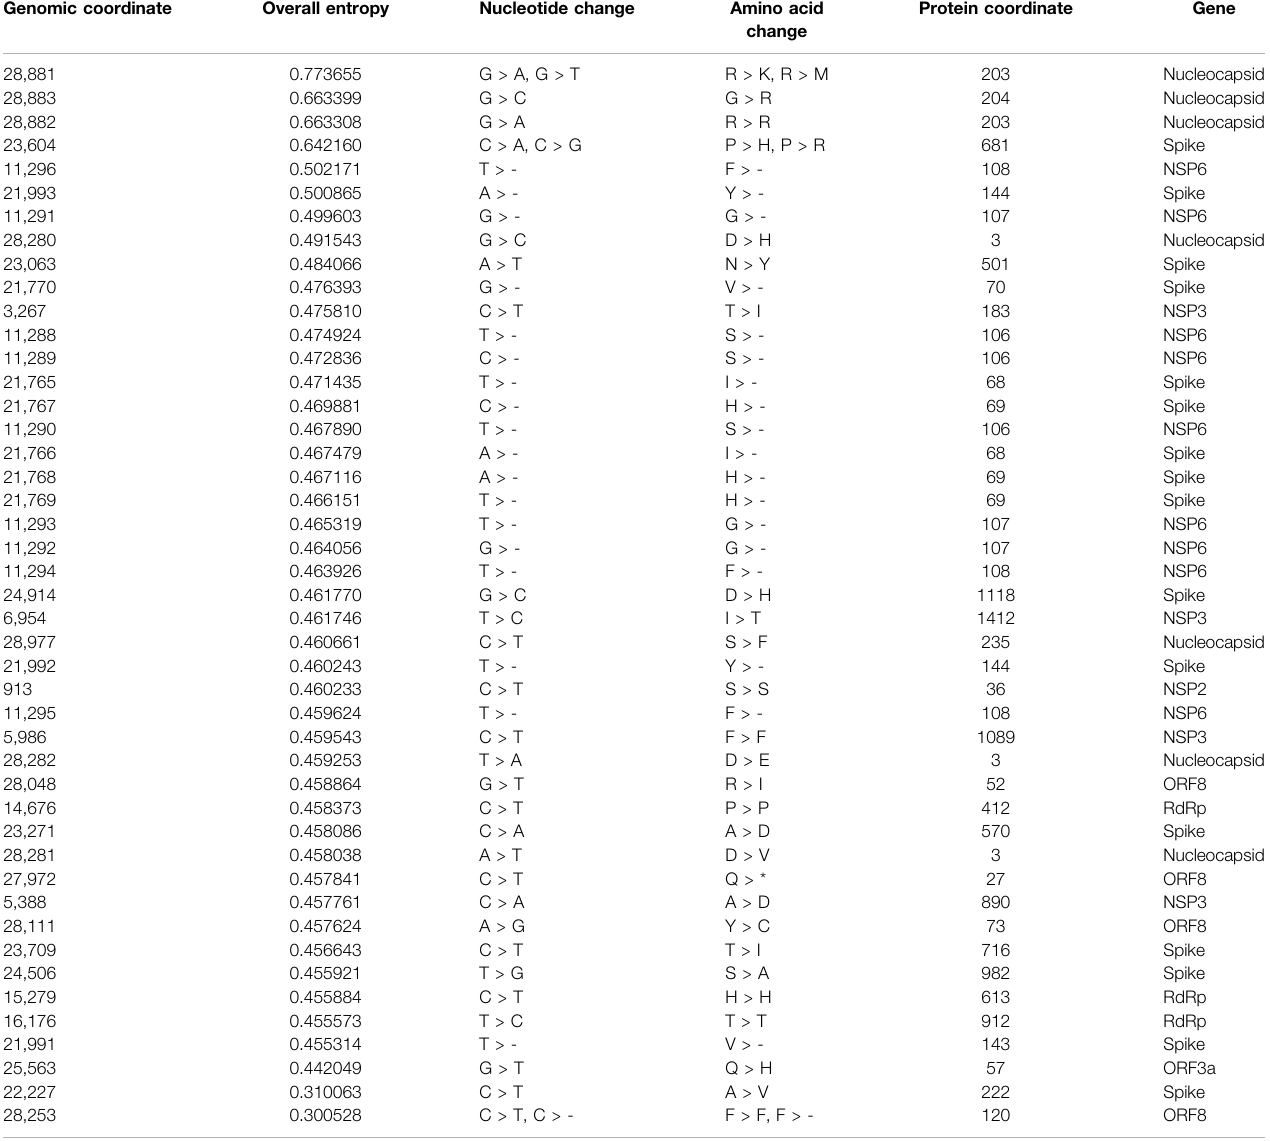
TABLE 2 | List of hotspot mutations for 71,038 global SARS-CoV-2 genomes along with the protein change. Genomic coordinate Overall entropy Nucleotide change Amino acid